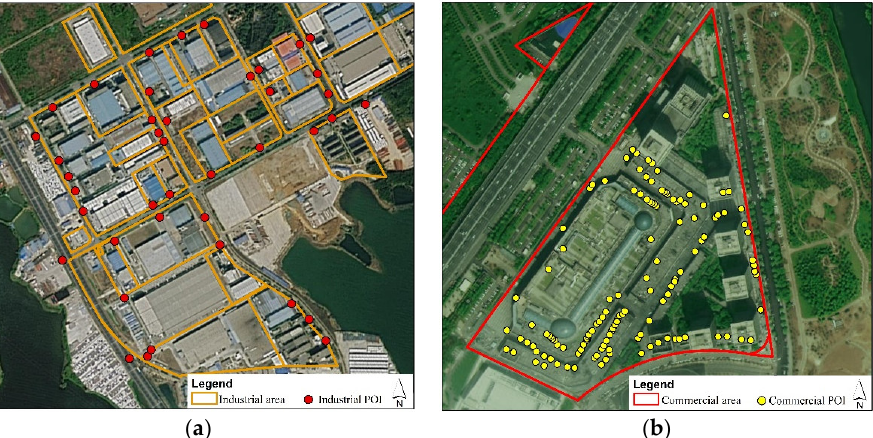
Figure 2. Industrial area ( a ) and commercial area ( b ) boundary derived from the land use map and industrial POI derived from Sina